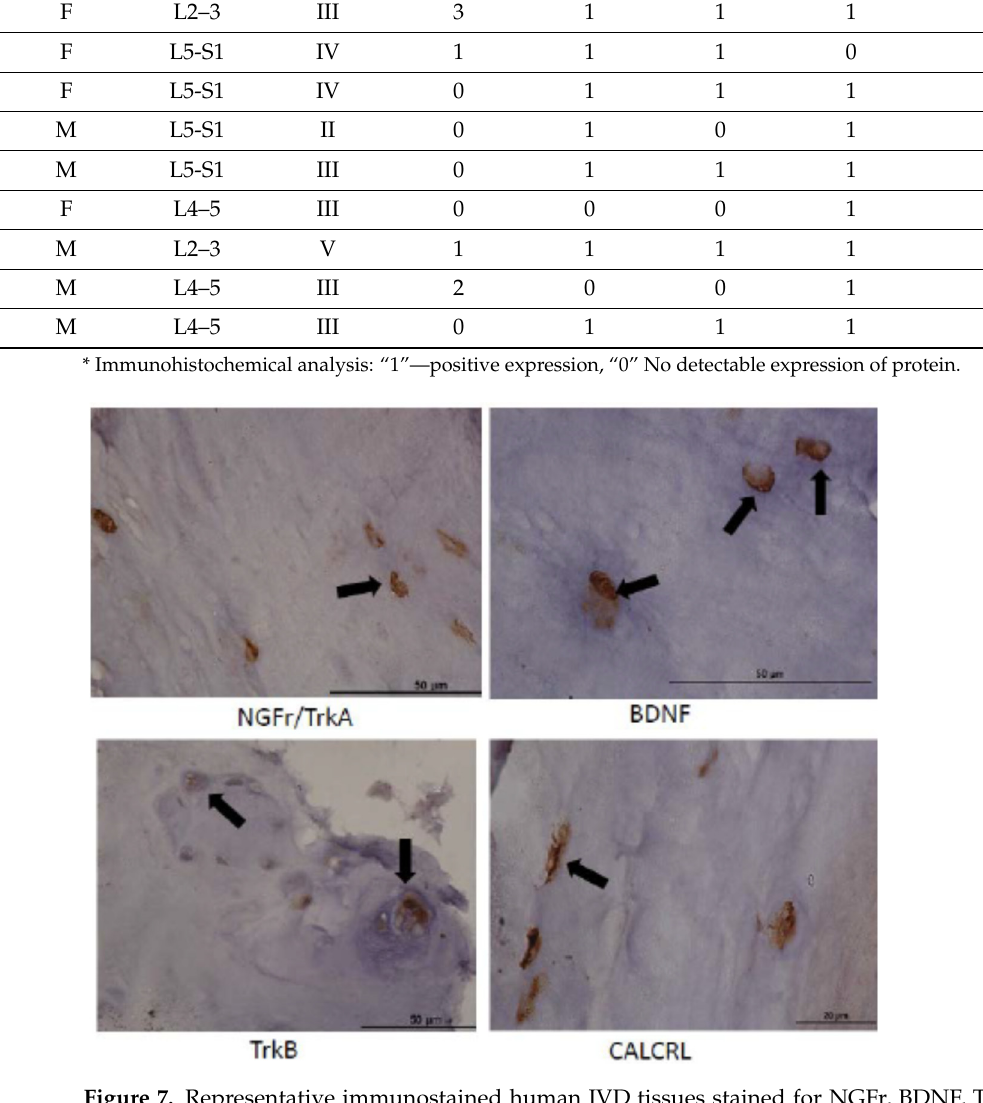
Figure 7. Representative immunostained human IVD tissues stained for NGFr, BDNF, TrkB and CALCRL (magnification × 90 oil immersion). Black arrows depict immunopositive cells for each respective